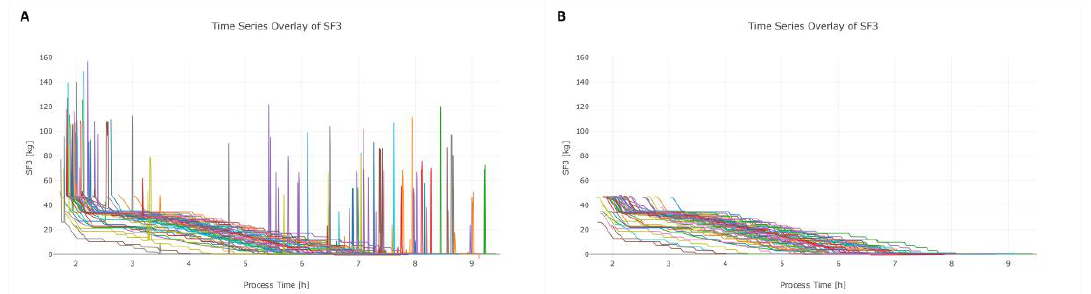
Figure 4. Data-cleaning algorithm applied on signal SF3. The raw SF3 signals of various lots (different colors) are depicted in ( A ), whereas the high peaks within the signal are caused due to stepping on the scale. These peaks have no further process-relevant information content and therefore need to be removed to enhance the performance for MVDA. In ( B ), the corrected SF3 signal is depicted after the cleaning algorithm was applied.